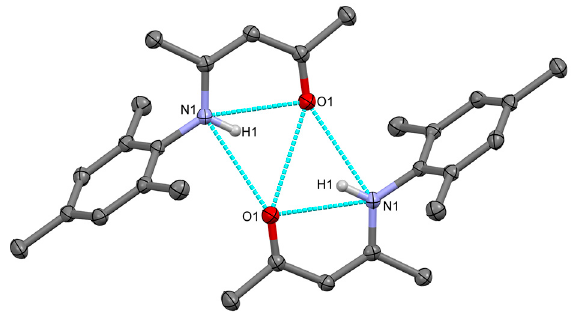
Figure A1. Depiction of the hydrogen-bonding that forms a centrosymmetric dimer in the structure of 1b . The dihedral angle between the N 1 –O 1 –N 1 ′ –O 1 ′ and the O 1 –C 2 –C 3 –C 4 –N 1 planes is only 16.5°.